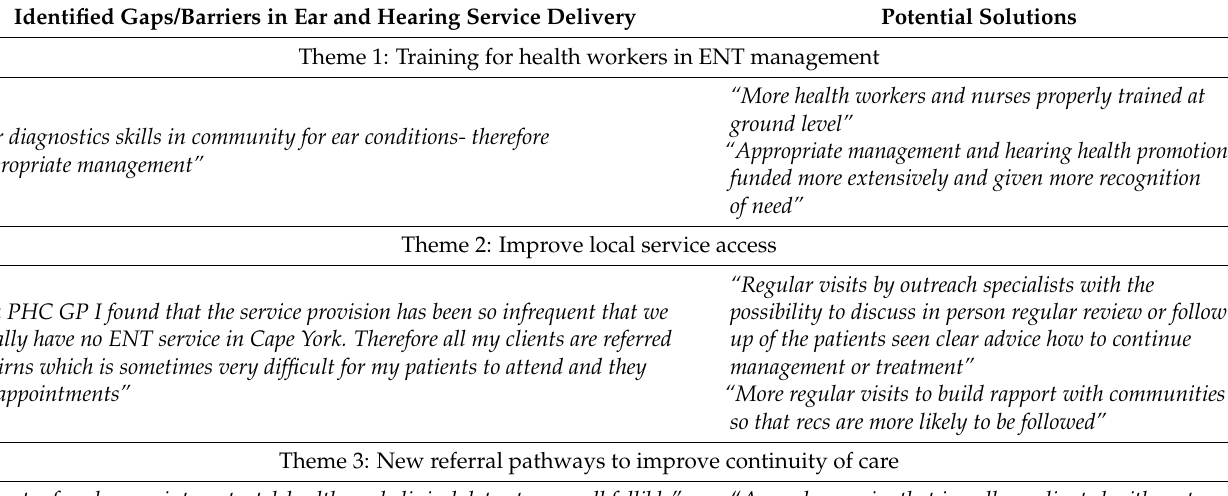
Table 3. Themes, barriers, and solutions identified at stakeholder forum and follow-up